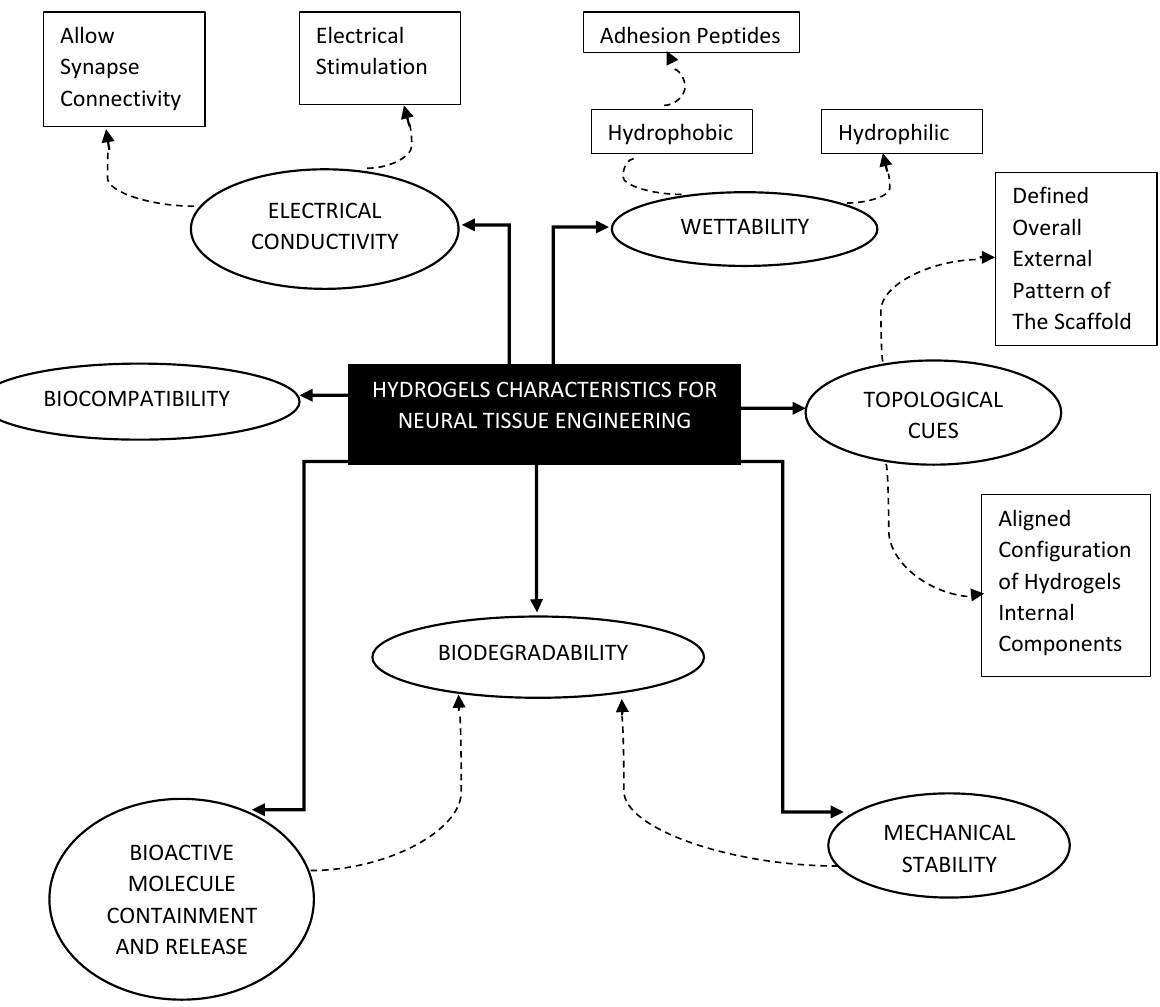
Figure 1. Desired characteristics of hydrogels chosen for scaffold fabrication.